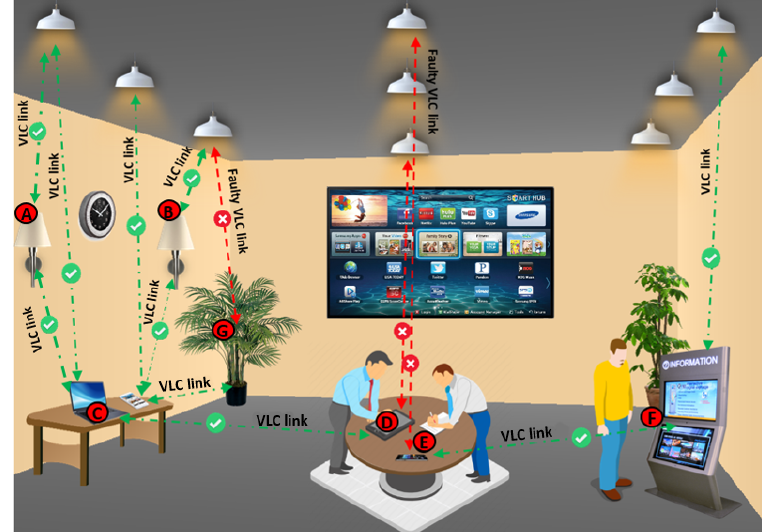
Figure 1. The proposed system model which consists of direct and relay